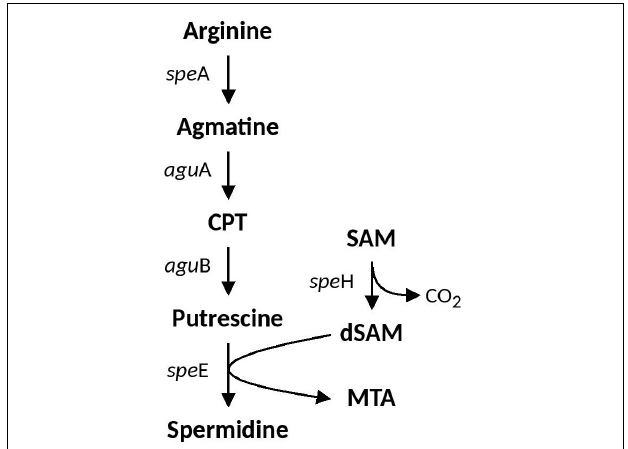
FIGURE 2 | Spermidine biosynthesis pathway identified in Acidihalobacter. CPT, N-carbamoylputrescine; SAM, S-Adenosyl methionine; dSAM, decarboxylated-Adenosyl methionine; MTA,